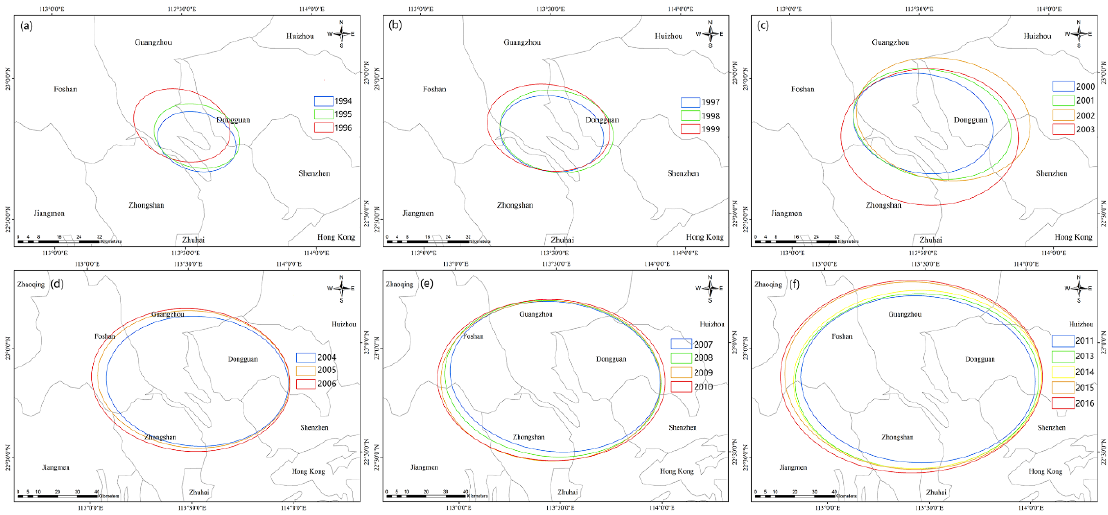
Figure 9. The standard deviational ellipses of the GHM Bay Area ( a ) between 1994 and 1996; ( b ) between 1997 and 1999; ( c ) between 2000 and 2003; ( d ) between 2004 and 2006; ( e ) between 2007 and 2010; ( f ) between 2011 and 2016. Table 2. The parameters of the standard deviational ellipses from 1994 to 2016.